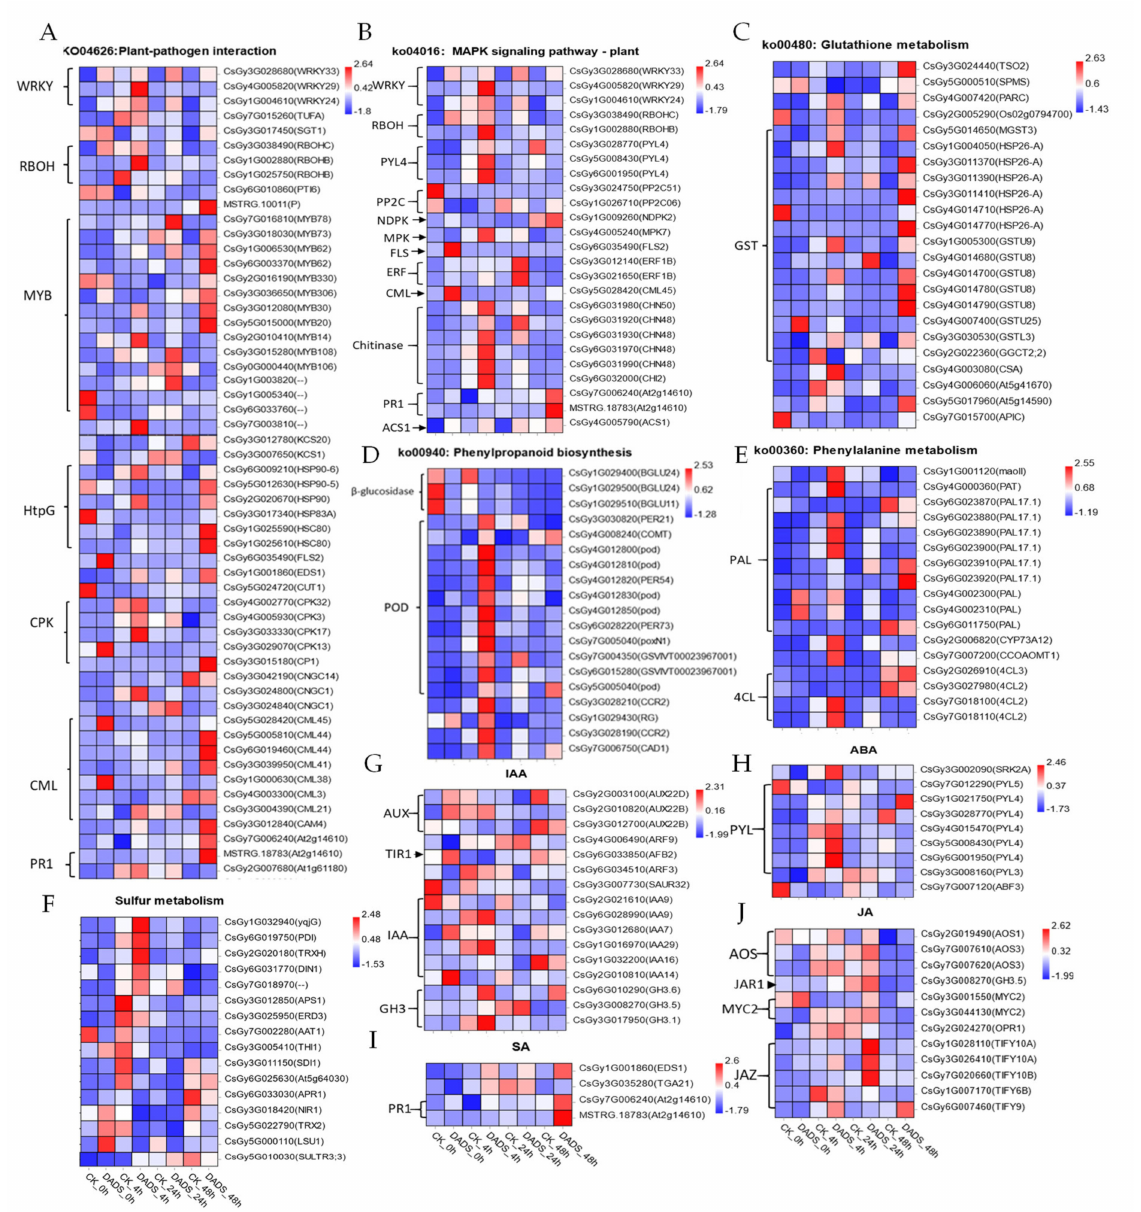
Figure 6. DEGs heatmap of DADS treated and CK leaves with P. cubensis infection. The bar represents the scale of the expression levels for each gene (FPKM) in the different treatments, as indicated by red/blue rectangles. Genes in red show upregulation, and those in blue show downregulation. ( A ) Plant–pathogen metabolism, ( B ) MAPK signaling pathway, ( C ) glutathione metabolism, ( D ) phenylpropanoid biosynthesis, ( E ) phenylalanine metabolism, ( F ) sulfur metabolism, ( G ) IAA genes, ( H ) ABA genes, ( I ) SA genes, and ( J ) JA